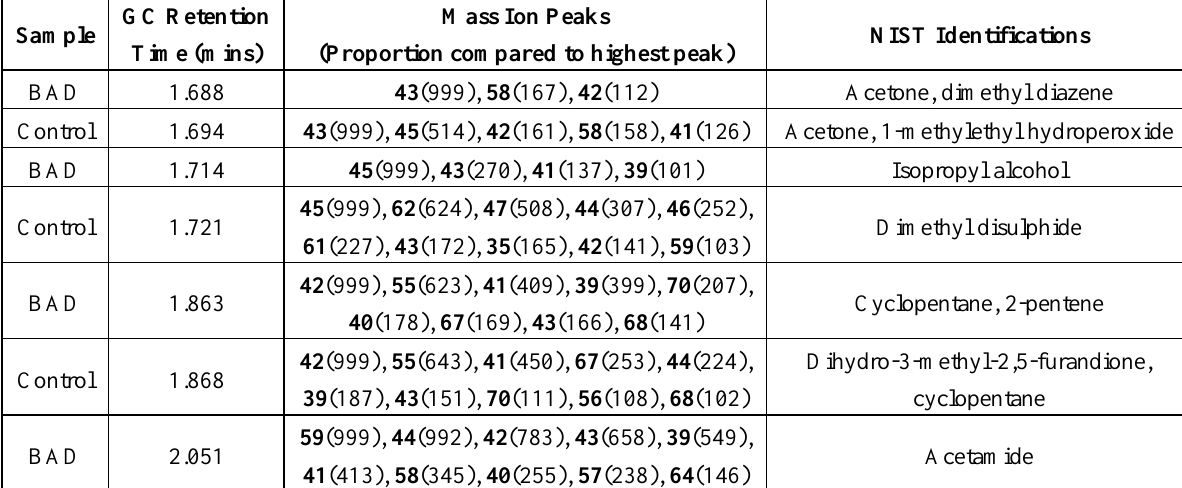
Table 2. Mass Ion Peaks and NIST Identifications of GC Peaks shown in Figure